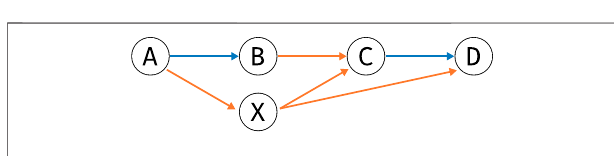
FIGURE 2 | Example of a graph where pruning removes node X, since both incoming and outgoing edges are exclusively of type split